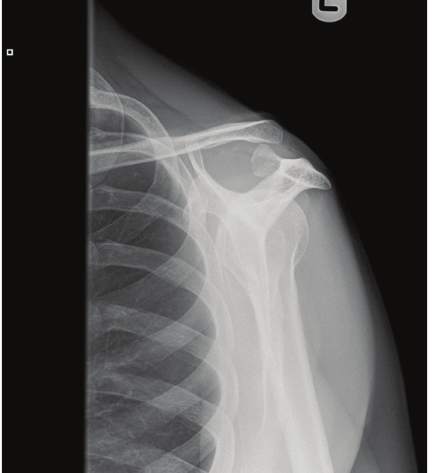
Figure 4: Y view radiograph taken in emergency department at initial